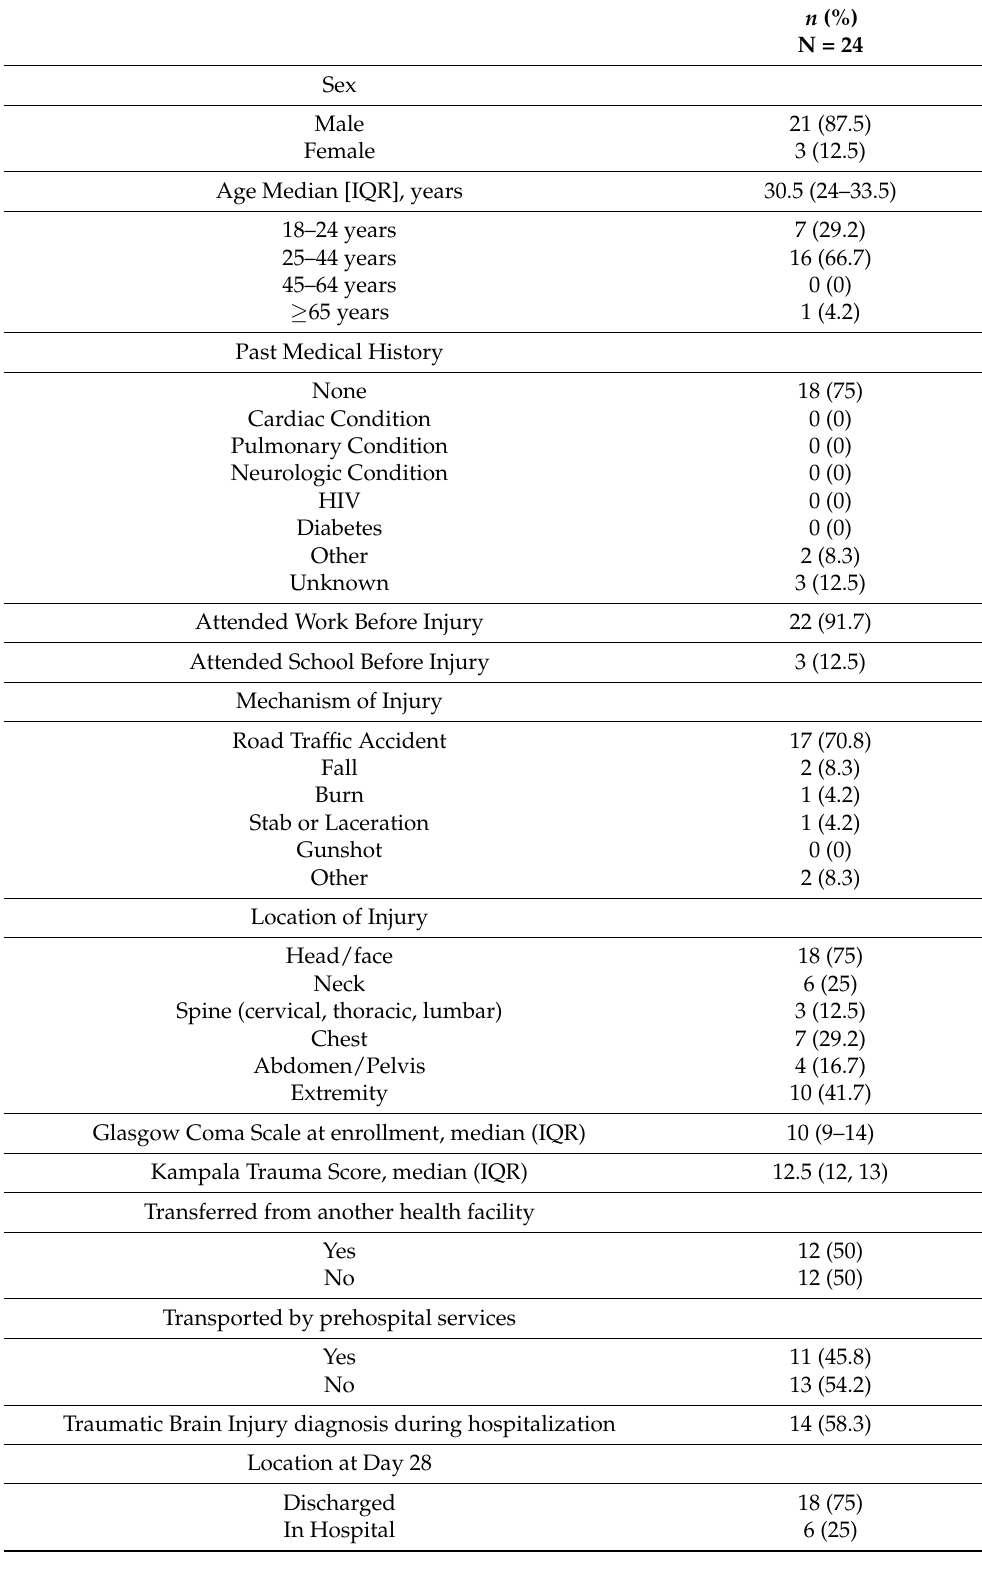
Table 1. Characteristics of the study